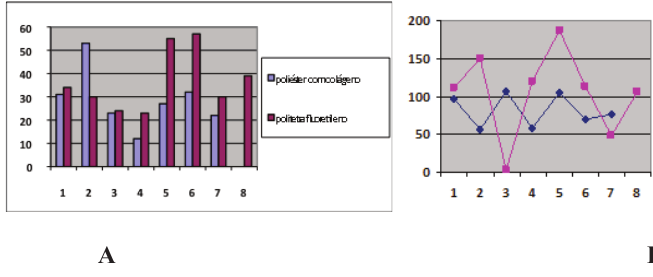
FIGURE 4 - Graphs of the breakdown ( A ) and maximum deformity ( B ) - 30 days.